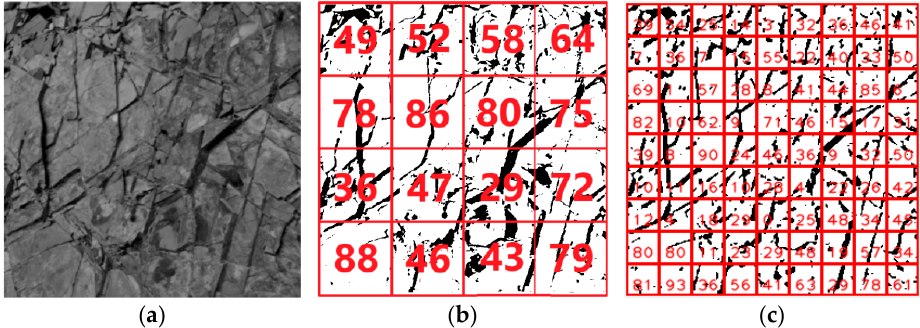
Figure 6. Fractal dimension. ( a ) Original image, ( b ) 4 × 4 fractal dimension, ( c ) 9 × 9 fractal